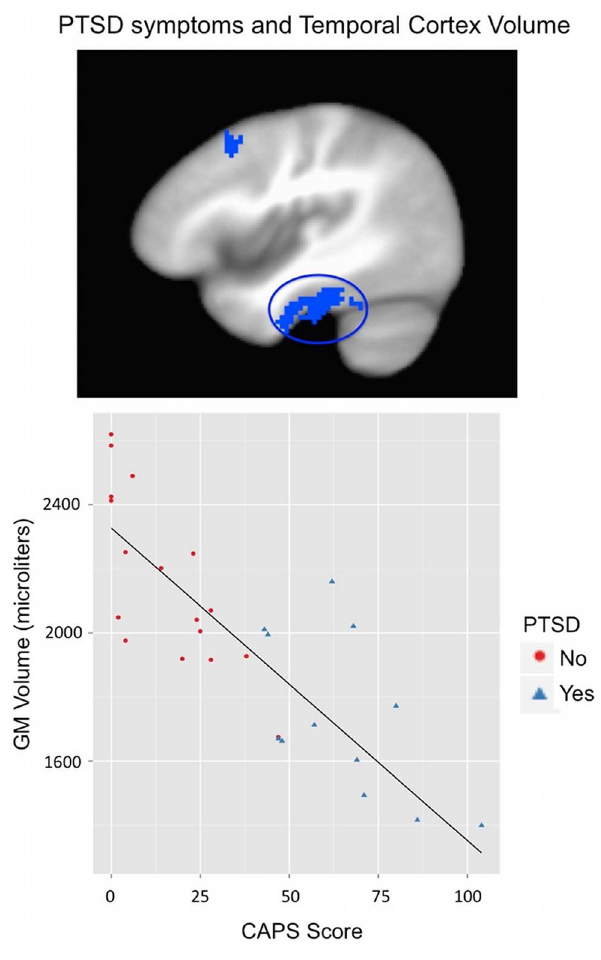
Figure 4. Individuals with more PTSD symptoms show reduced gray matter volume within the inferior temporal gyrus. PTSD symptoms were measured using the total severity score from the Clinician Administered PTSD Scale (CAPS). Greater severity score on the CAPS related to reduced gray matter volume in the right inferior temporal gyrus (BA 20; spreading to parahippocampal and fusiform gyrus; shown at x=42). See Table